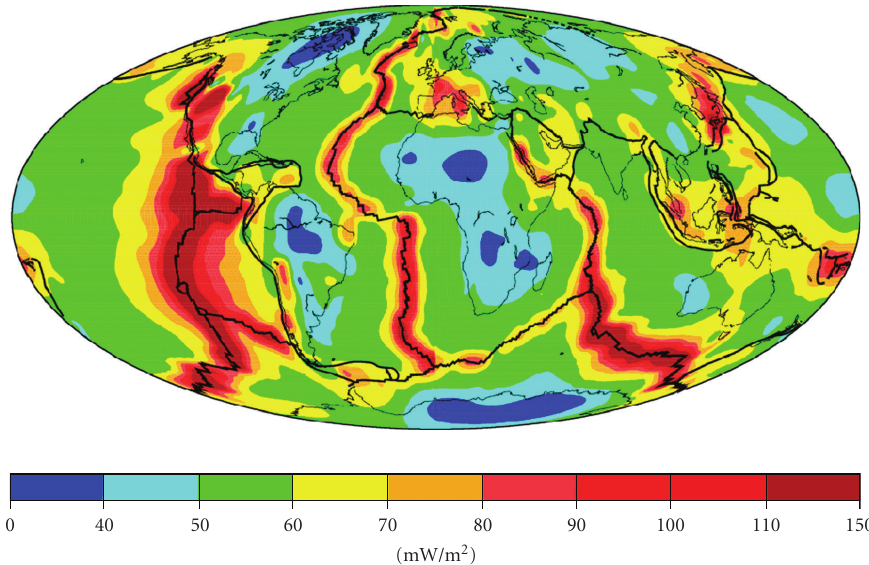
Figure 11: Global heat flow map derived from mixed data sets. For oceanic regions with ages less than 120 Ma heat flow values are calculated using (14a) and (14b) with age values derived from a global grid at 0 . 1 ◦ spacing (Muller et al. [59]). For continental regions and remaining areas heat flow values are derived from IHFC data set, following the procedure outlined for higher-degree harmonic representation (Hamza et al.